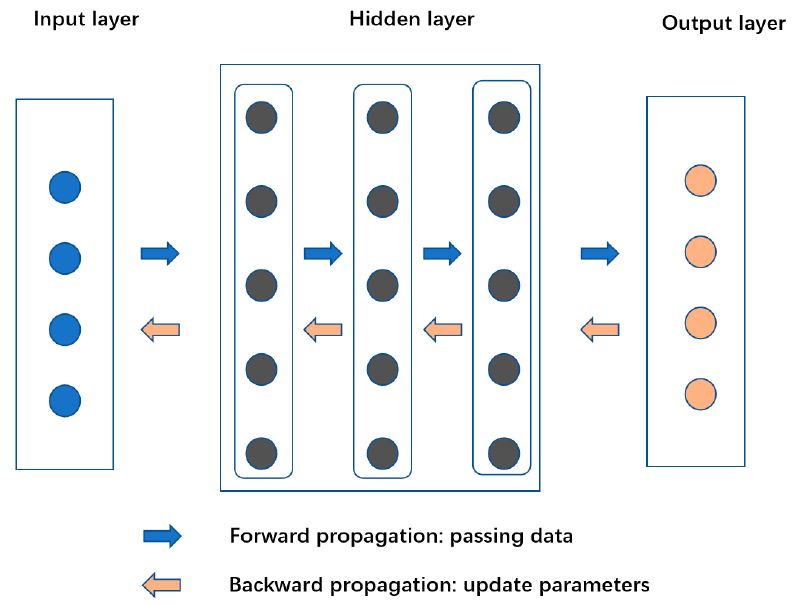
Figure 7. Forward and backward propagation of artificial neural networks.